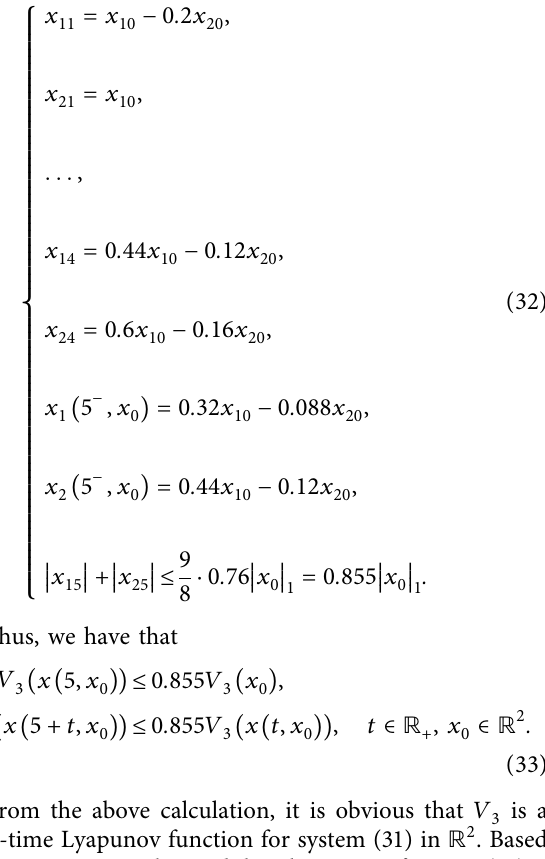
Figure 2: The trajectory of the state of system (28) corresponding to the initial condition x ( 0 ) � 64 and the resetting time t � 0 . 5 k, k � 1 , 2 , ... , k